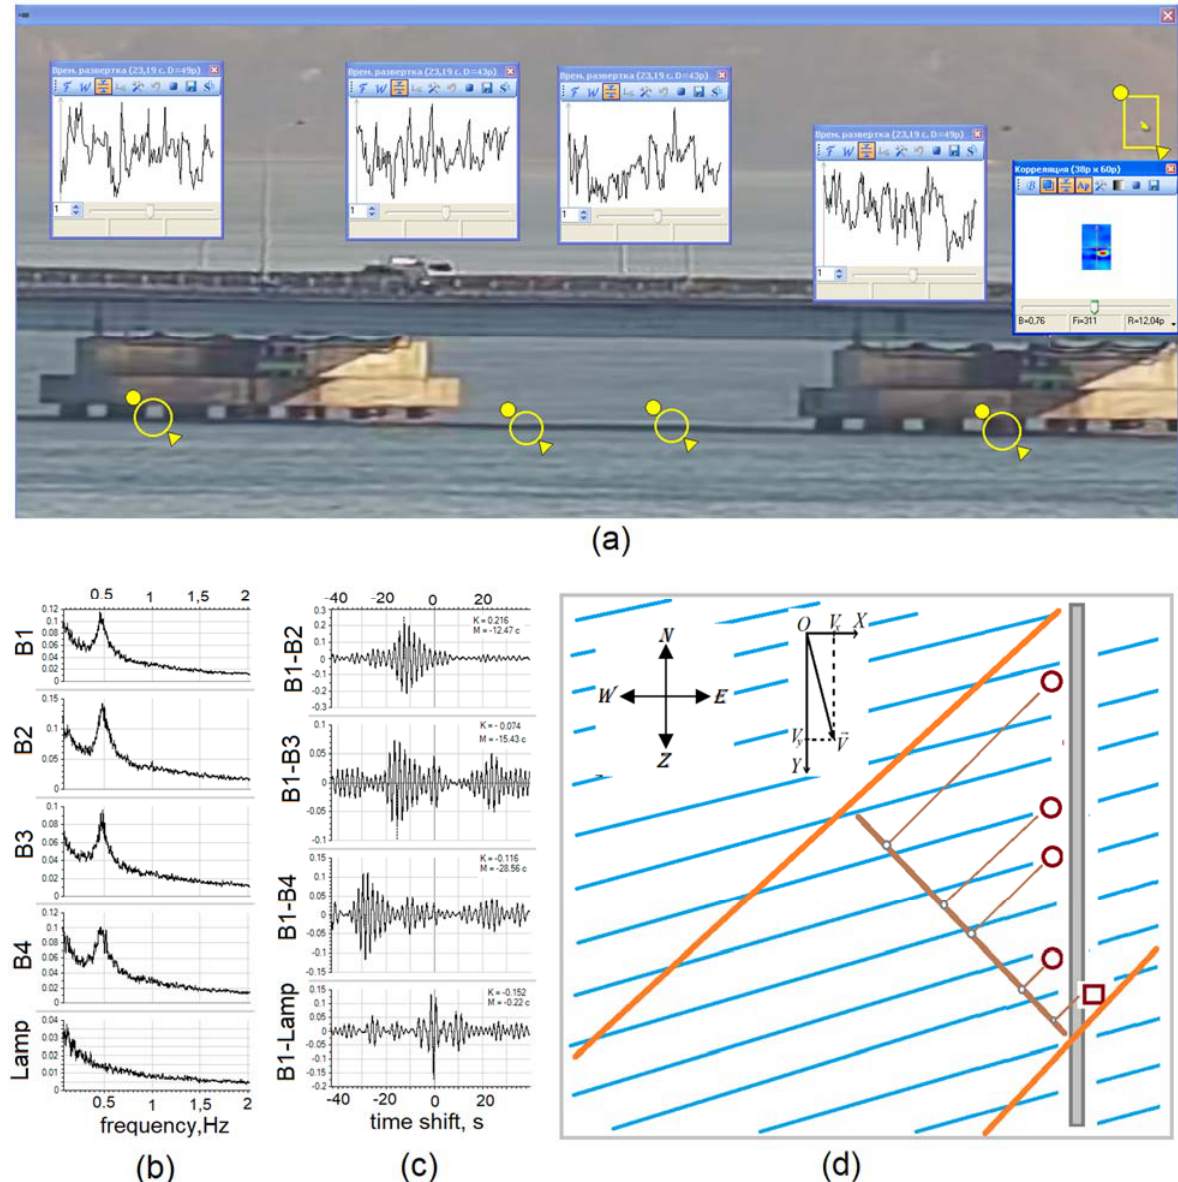
Figure 16. Registration of wind waves near the low-water bridge on 14–15 October 2020: ( a ) placement of meters on the 18 video scene; ( b ) Fourier spectra of two-hour signal records; ( c ) mutual correlation functions between signals; ( d ) schematic map of the